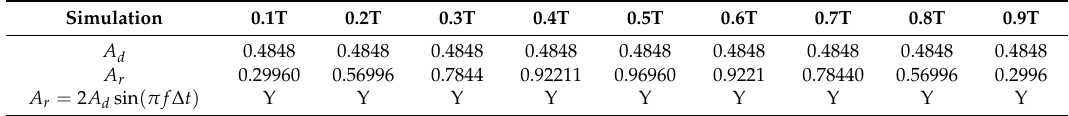
Table 1. The amplitudes of simulated jitter displacements and registration errors at different imaging time intervals.